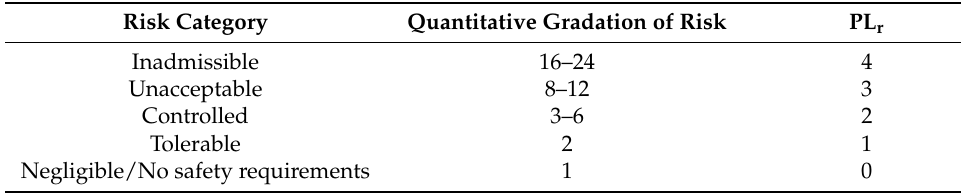
Table 2. Quantitative scale of risk for the particular water-supply